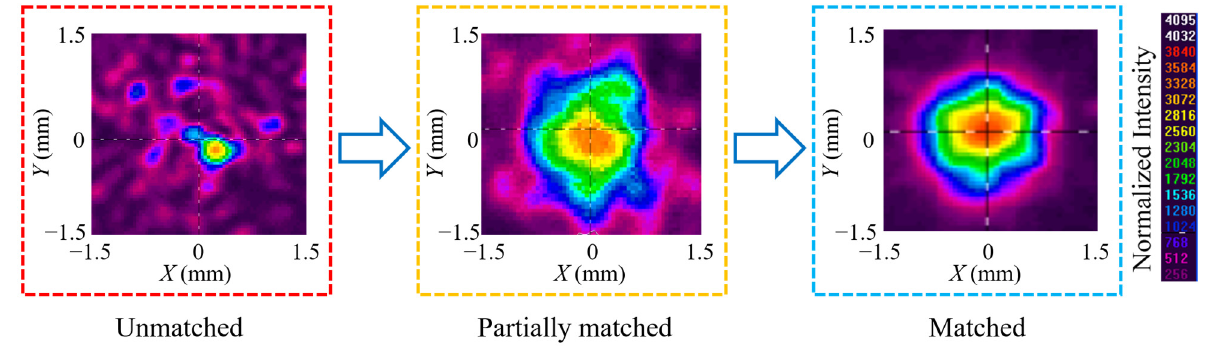
Figure 1. The mode field of coupling 5 W fiber laser into aeroGAINRODPM85 rod fiber.